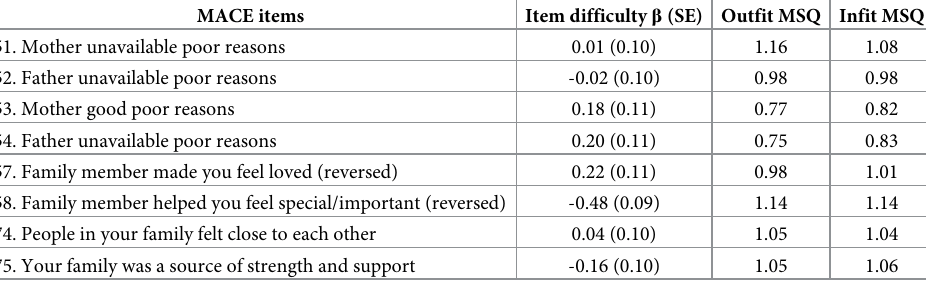
Table 9. Rasch analysis of emotional neglect